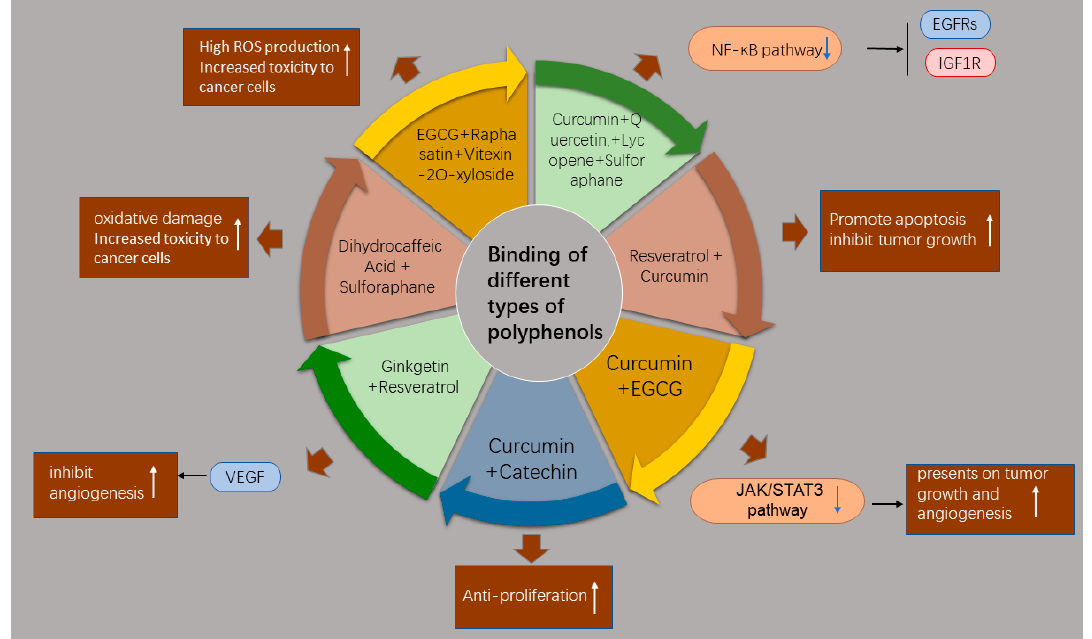
Figure 5. The mechanism diagram of the enhancement of anti-tumor efficacy of combined multi-type polyphenols. White arrows show enhanced efficacy and blue clippings show downregulation.